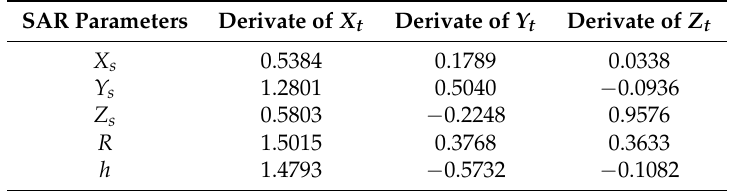
Table 1. The derivates of geolocation with respect to SAR parameters on 20080131 and 20080317. SAR Parameters Derivate of X t Derivate of Y t Derivate of Z t X s 0.5384 0.1789 0.0338